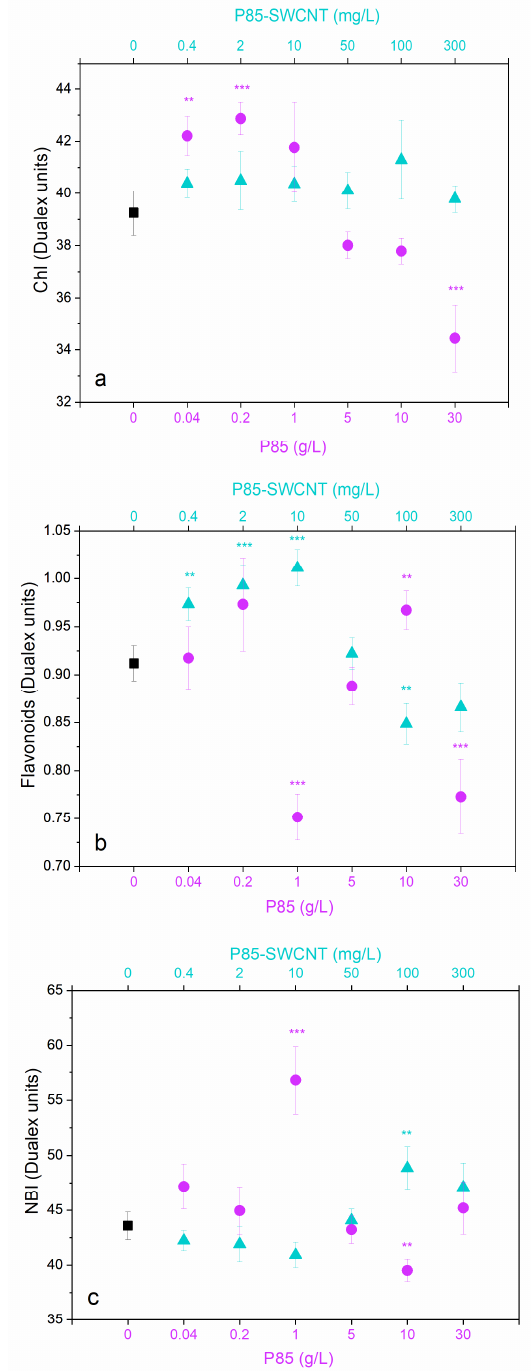
Figure 3. Adaxial leaf surface characterization for plants developed from hydro-, P85-SWCNT, and P85-primed seeds. Data are obtained on intact leaves at the 14th day after seeds sowing. Total chlorophyll (Chl) content ( a ), total flavonoids content ( b ), nitrogen balance index (NBI, ( c )). Mean ± SE. Statistically significant differences from the control sample at p < 0.05 (**), p < 0.01 (***) according to Student’s t -test are indicated with the respective colors (violet for P85 and cyan for P85-SWCNT treatments).